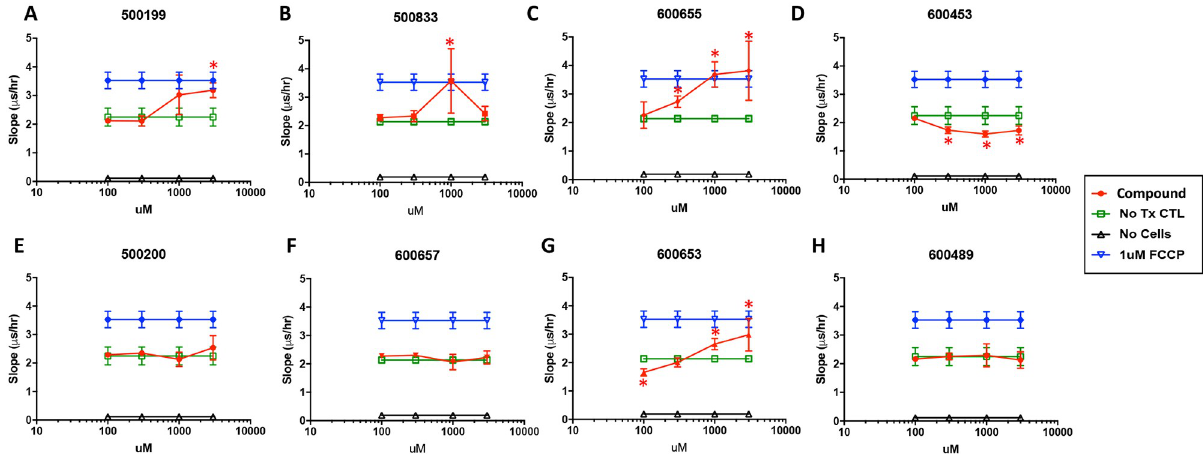
Fig 3. Dose dependent changes in oxygen consumption rate (OCR). Cellular respiration rate was measured in HEK293 cells expressing human OCT1 using the Mitoexpress-Xtra kit. The lifetime slope was plotted against concentration of compound. Oxygen consumption measurements were obtained immediately after treatment and for a period of 2 hours. The slope was calculated from the linear portion of the 2-hour kinetic run. Basal respiration (no treatment, green), stimulated respiration (1uM FCCP, blue) and no cell control (black) are shown. Changes with � indicate statistically significant (p < 0.05) OCR values compared to basal OCR values.